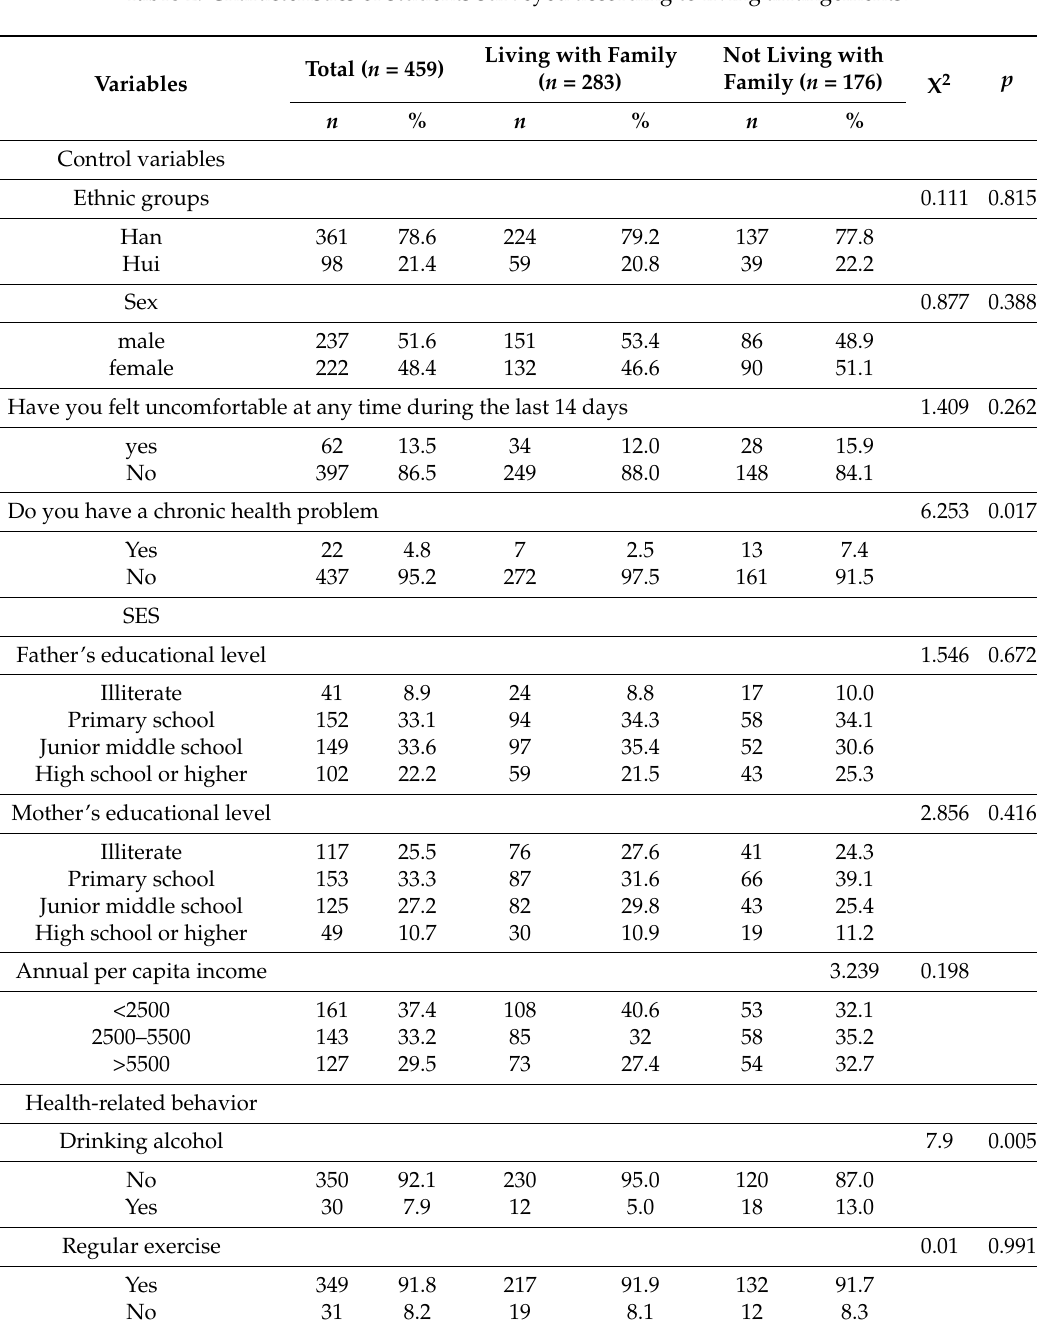
Table 2. Characteristics of students surveyed according to living